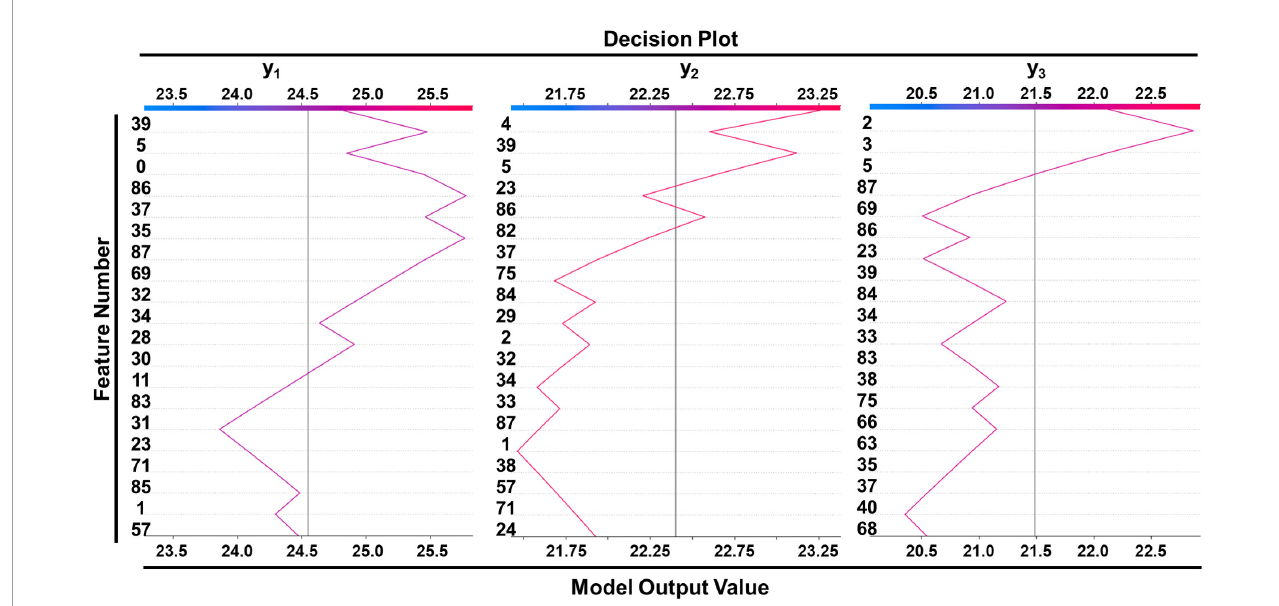
FIGURE5 Decision plot of a single sample showed how included features affected prediction in SVM model. Corresponding features of feature numbers were shown in Supplementary Table 1